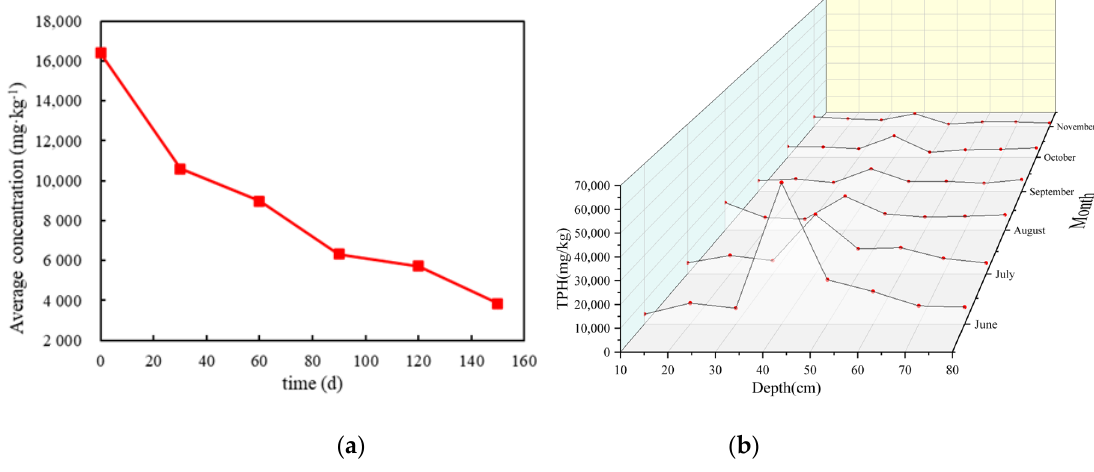
Figure 11. ( a ) Variation in the average concentration of TPHs and ( b ) monthly concentrations of different points in the M-F-C tank.